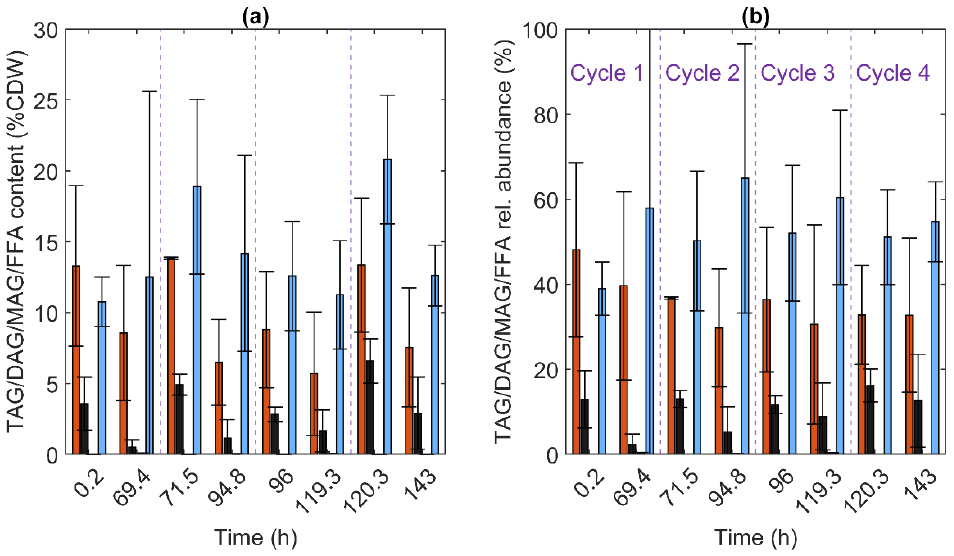
Figure 8. Evolution of ( a ) the %CDW of lipids and ( b ) the relative abundance of lipids, with ( ■ ) triacylglycerides (TAGs), ( ■ ) diacylglycerides (DAGs), (□) monoacylglycerides (MAGs), and ( ■ ) free fatty acids (FFAs) for R. kratochvilovae during the fermentation. Vertical dashed lines (--) indicate the end of each cycle. The %CDW and relative abundance are the averages of three analytical repeats, the error bars present the standard deviation. Outliers, points that were three scaled median absolute deviations away from the median of its group, were removed.